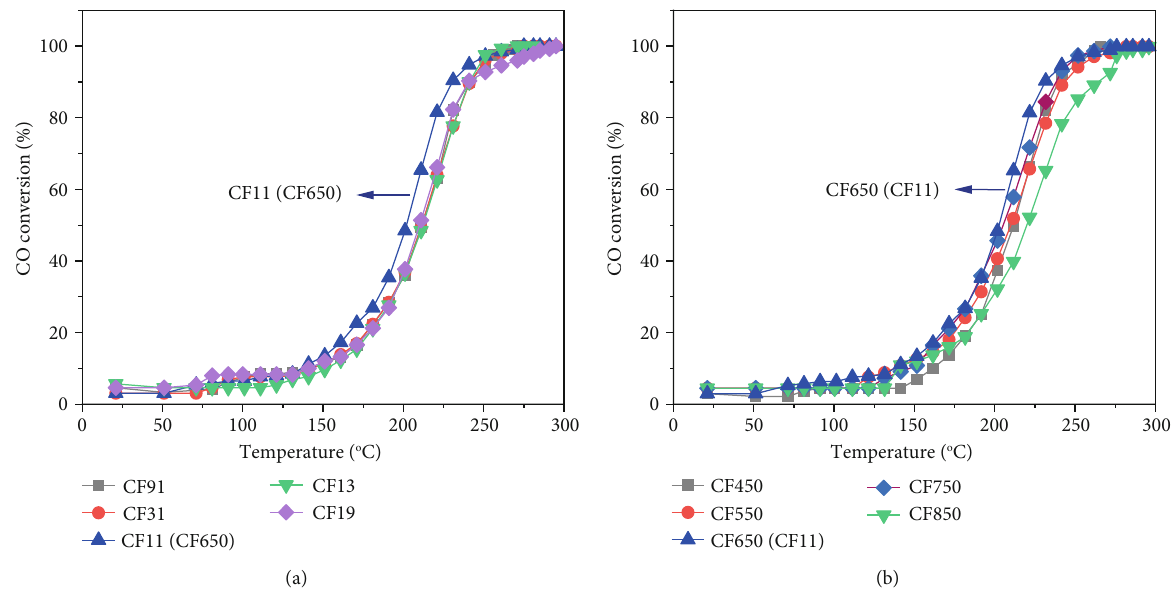
Figure 7: CO conversion of CeO (a) and samples calcined at di ff erent temperatures for 2h